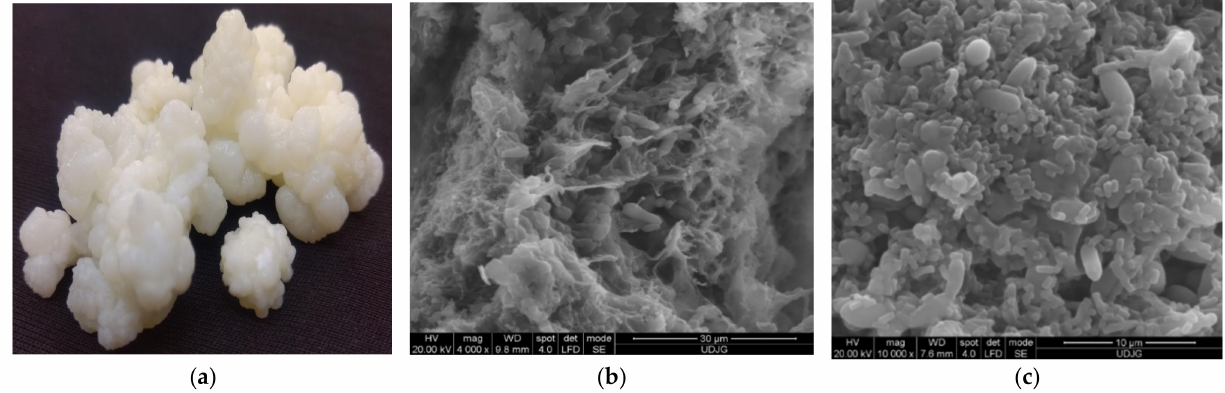
Figure 4. Milk kefir grains ( a ) and Scanning Electron Microscopy (SEM) micrographs of milk kefir grains in the section at × 4000 magnification ( b ), at the surface at × 10,000 magnification ( c